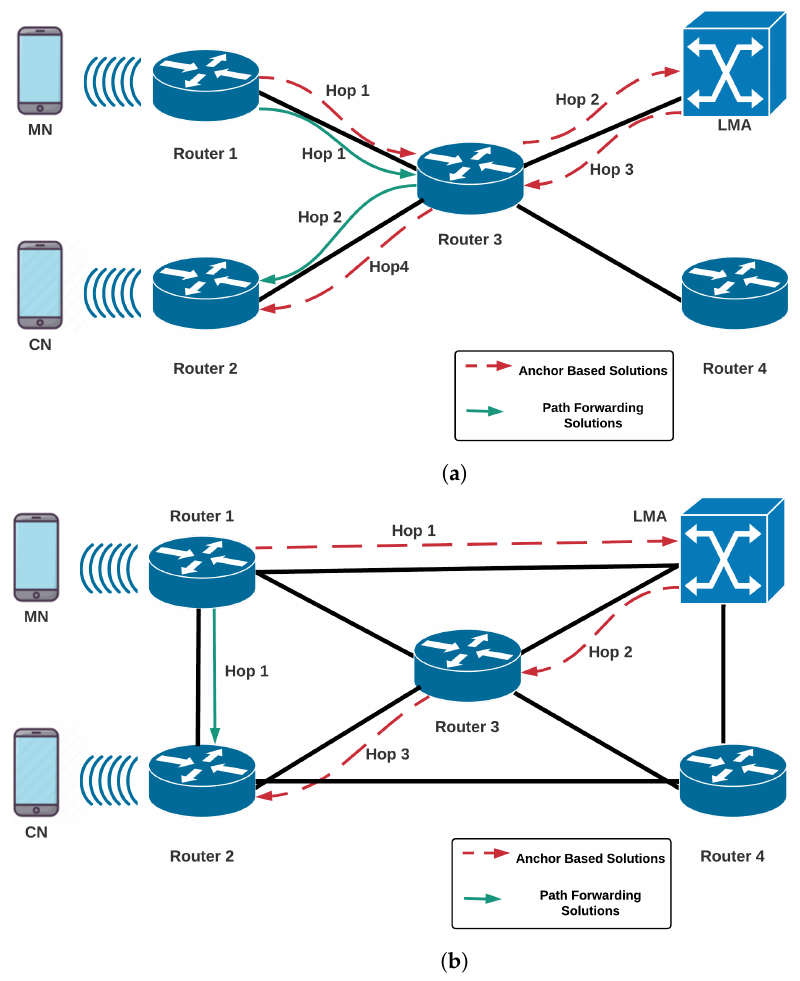
Figure 5. Packet Delivery Routes in Path Forwarding vs Anchor Based Networks. ( a ) Example Topology 1; ( b ) Example Topology